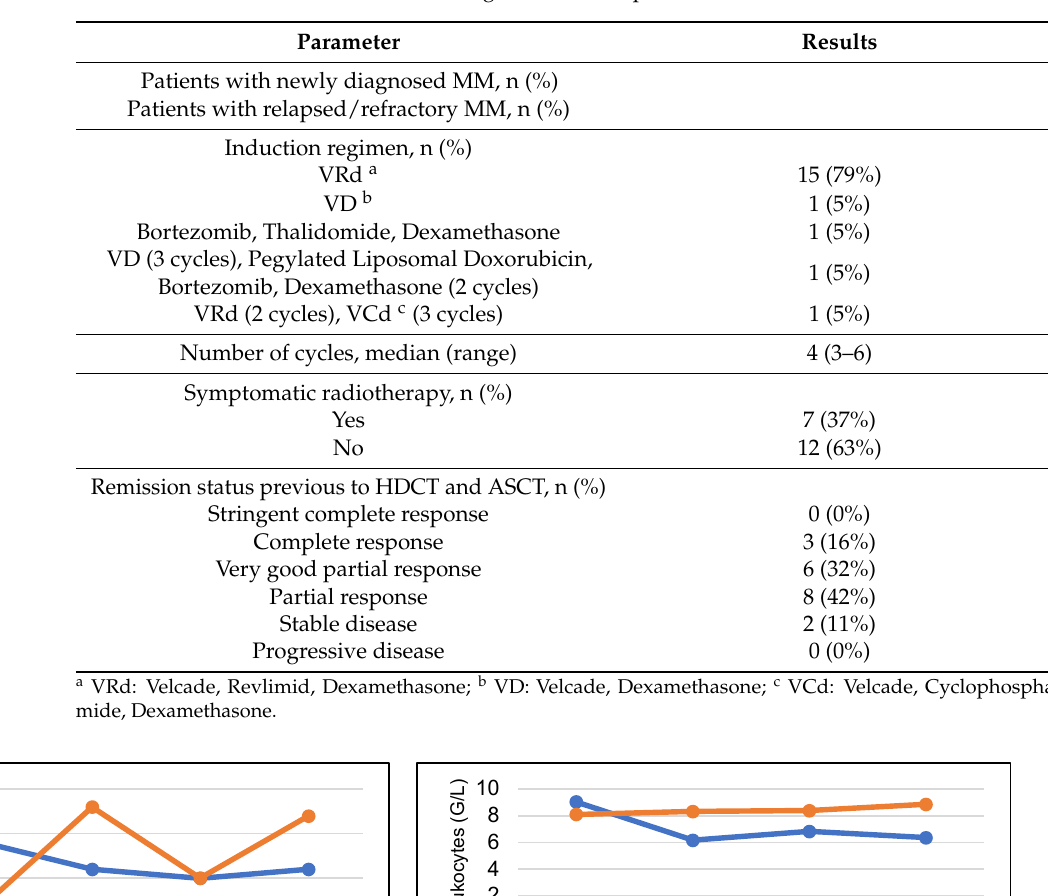
Table 2. Details of induction treatment regimens and responses before stem cell mobilization.